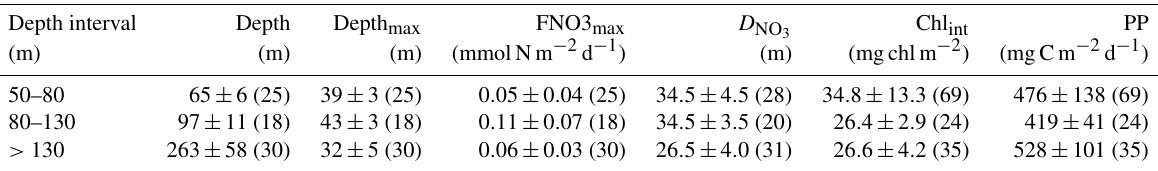
Table 2. Median values and absolute median deviations of all data in three depth intervals, depth of maximum nitrate flux (Depth max ), maximum nitrate flux into the euphotic zone (FNO3 max ), depth of nutricline ( D NO production (PP).